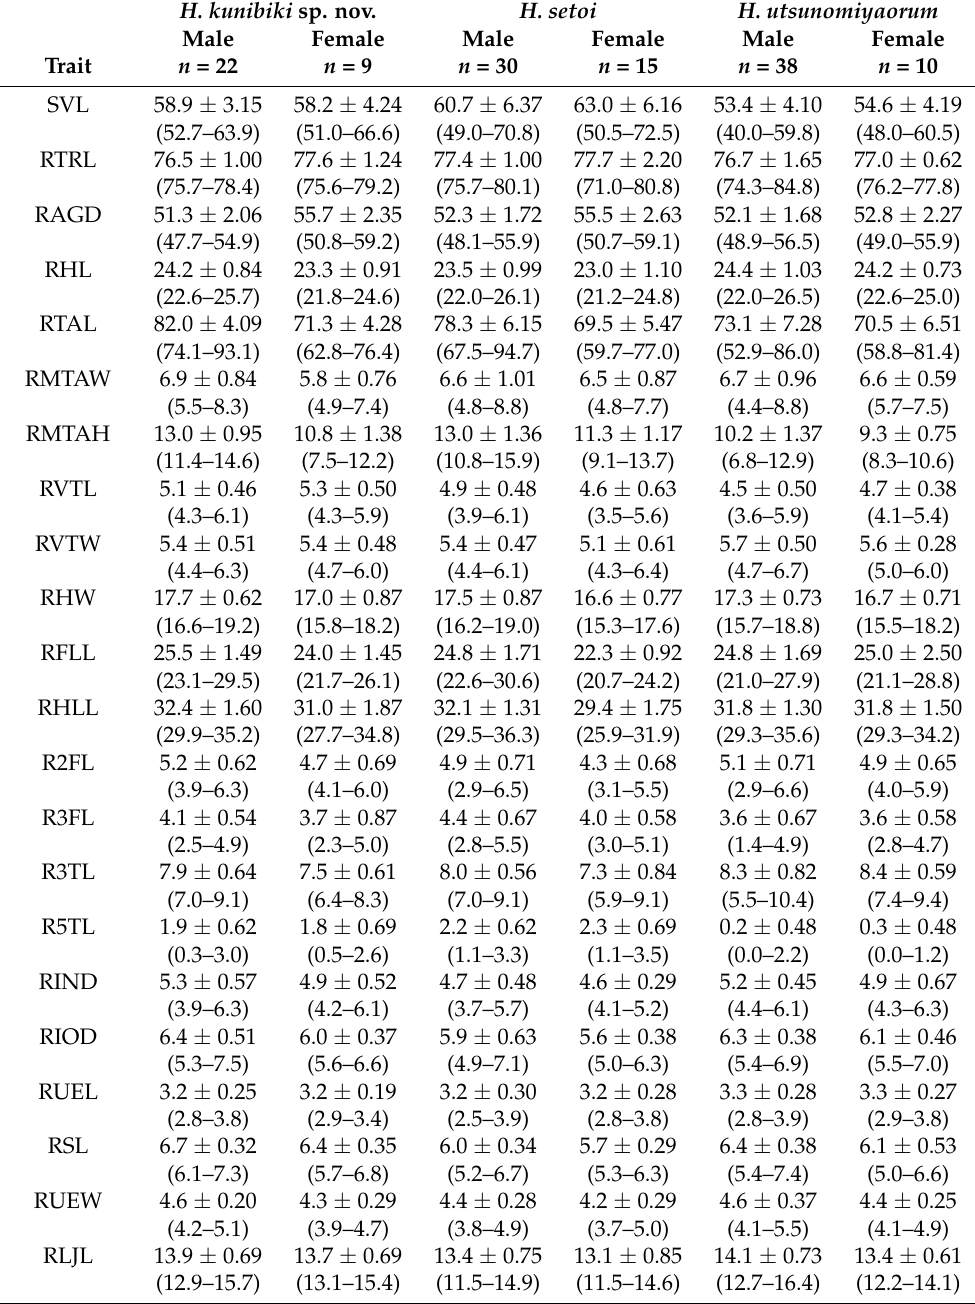
Table 1. Measurements (mm) of snout–vent length (SVL) and character ratios (R = %SVL) of trunk length (TRL) to lower jaw length (LJL) of the three species of Hynobius collected in 2018–2021 ( n = number of individuals). Values are reported as means ± standard deviation. Ranges are shown in parentheses. See Materials and Methods section for definitions of morphological